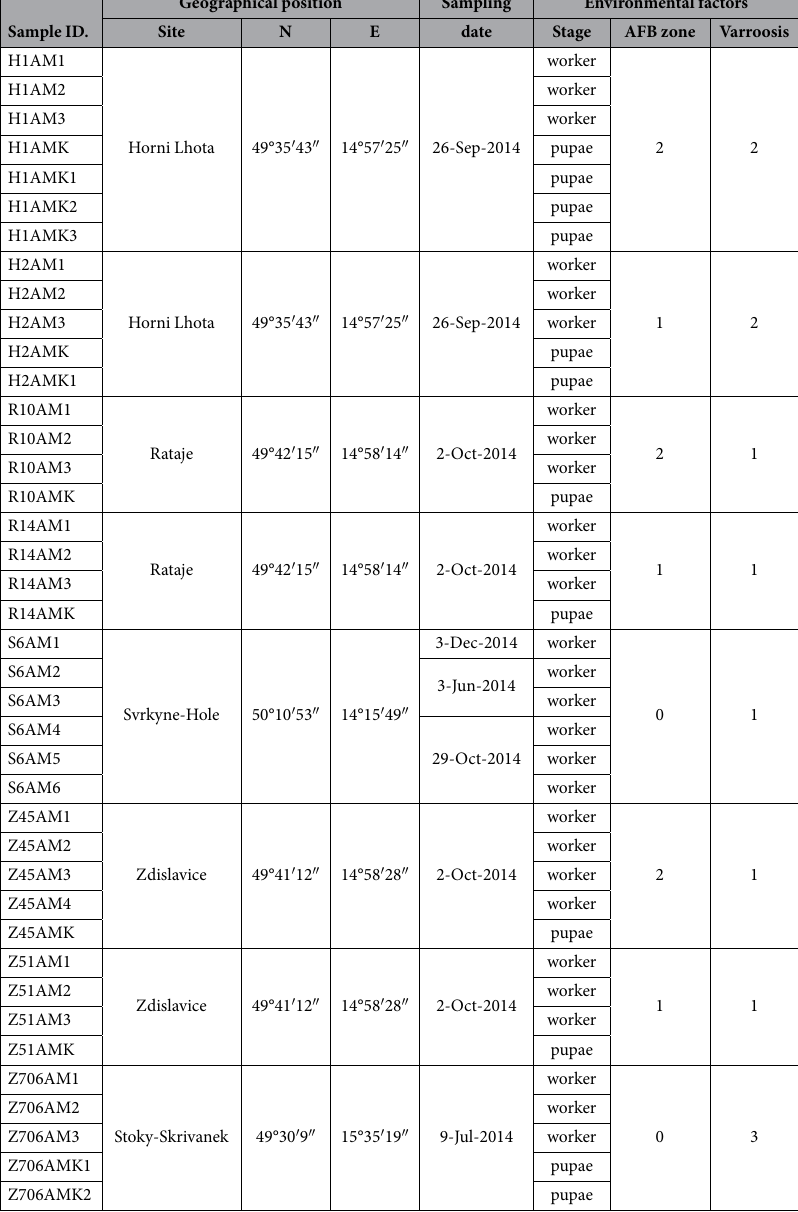
DNA extraction from honeybees. Each worker sample was surface-sterilized by washing in pure etha- nol, followed by rinsing three times with sterile phosphate-buffered saline (3.2 mM Na 2 HPO 4 , 0.5 mM KH 2 PO 4 , 1.3 mM KCl, and 135 mM NaCl) containing 0.05% w/w Tween ® 20 detergent (PBS-T) (Sigma-Aldrich, Saint Louis, MO, USA) to remove the surface microflora. The pupae were not surface-treated. Worker or pupal samples were homogenized (whole-body homogenates) in 6 mL of sterile PBS-T in a glass Potter-Elvehjem homogenizer (Kavalier, Sazava, Czechia). The homogenates were transferred to sterile tubes (cat no. D1003; KRD, Prague, Czechia) and centrifuged (CL31R, Thermo Fisher Scientific, Waltham, MA, USA) at 845 × g for 5 minutes. The supernatants were mixed with 6 mL of phenol/chloroform/isopropanol (Roti-Phenol ® , cat no. A156.2, Carl Roth, Karlsruhe, Germany) and centrifuged at 3,381 × g for 5 minutes. This step was repeated with the upper aqueous phase, which was extracted twice with chloroform:isopropanol (24:1) and centrifuged. The upper aqueous phase